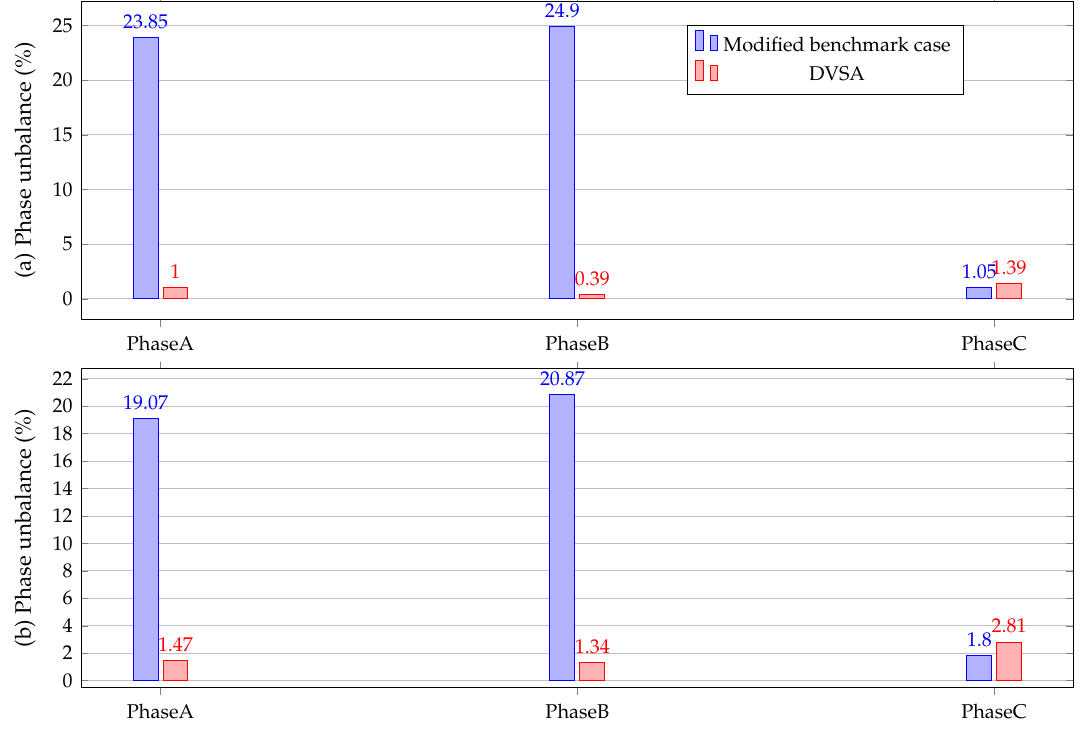
Figure 14. Unbalanced percentage of the 25-node test system: ( a ) active power and ( b ) reactive power.